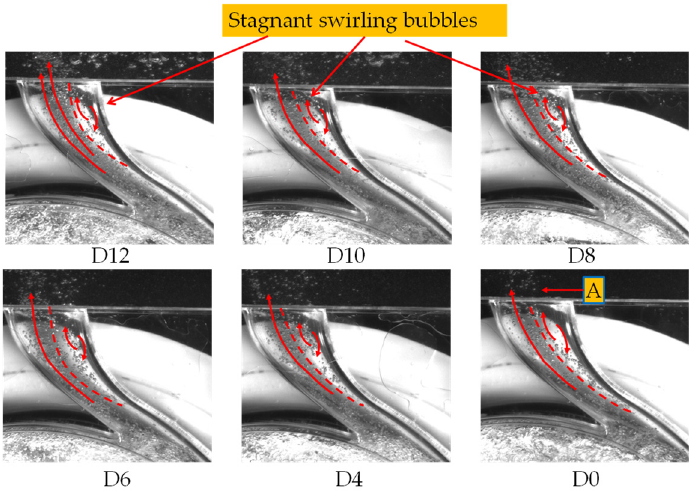
Figure 10. Bubble trajectory in volute at 10 s with different reflux areas.